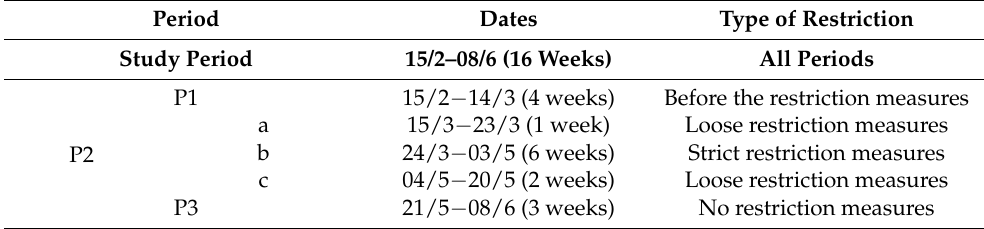
Table 1. The periods and their corresponding dates based on the lockdown measures. Period